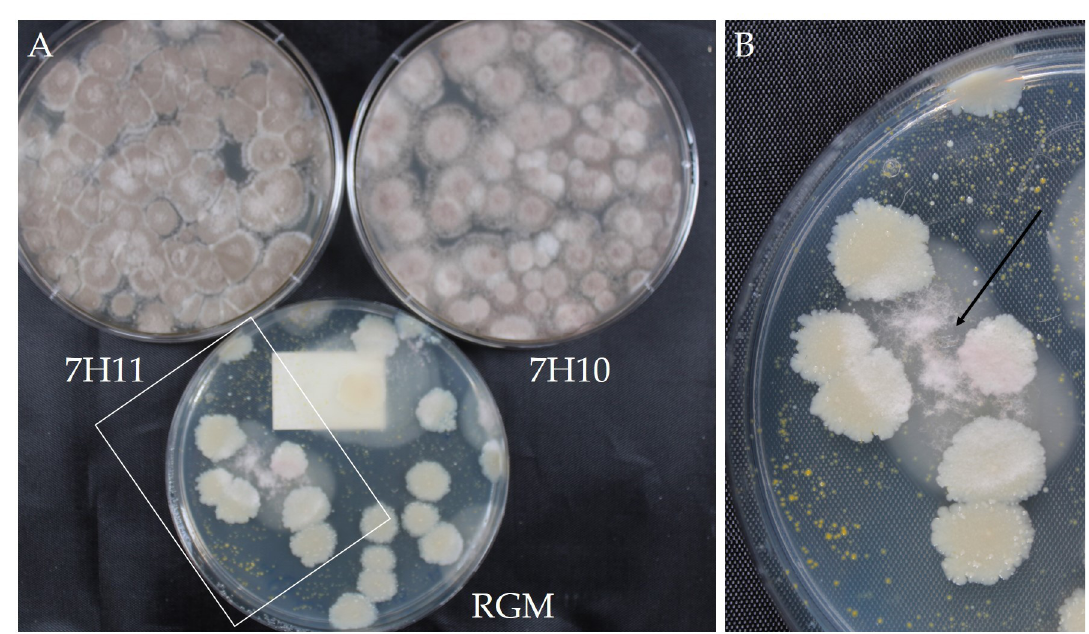
Fig 2. Visual comparison of Purpureocillium lilacinum on 7H10, 7H11, and RGM medium after six weeks of incubation. A) The 7H10 and 7H11 plates were overgrown with this fungus however the RGM medium partially inhibited the growth allowing recovery of NTM. B) Close up of inhibited growth of fungus from white box, black arrow shows the P . lilacinum colony. This was the only isolate of non-mycobacteria recovered from 223 environmental samples using RGM